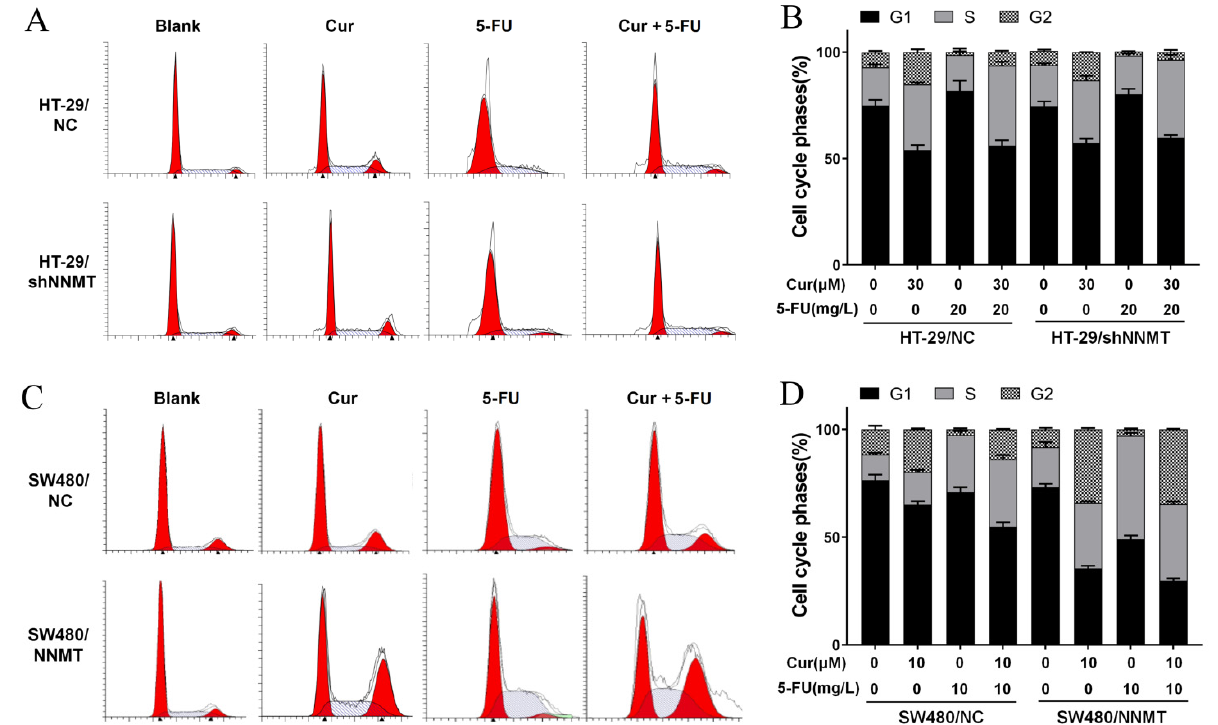
Figure 5. Cur combined with 5-FU induces cell cycle arrest in CRC cells. Cells were treated with Cur and/or 5-FU for 24 h. The untreated groups are displayed as blank groups. ( A , B ) Cell cycles were analyzed by flow cytometry and are displayed as a histogram in HT-29 cell lines. ( C , D ) Cell cycles were analyzed by flow cytometry and are displayed as a histogram in SW480 cell lines. 5-FU: 5-Fluorouracil, Cur: curcumin. Data are expressed as means ± SD, n = 3.